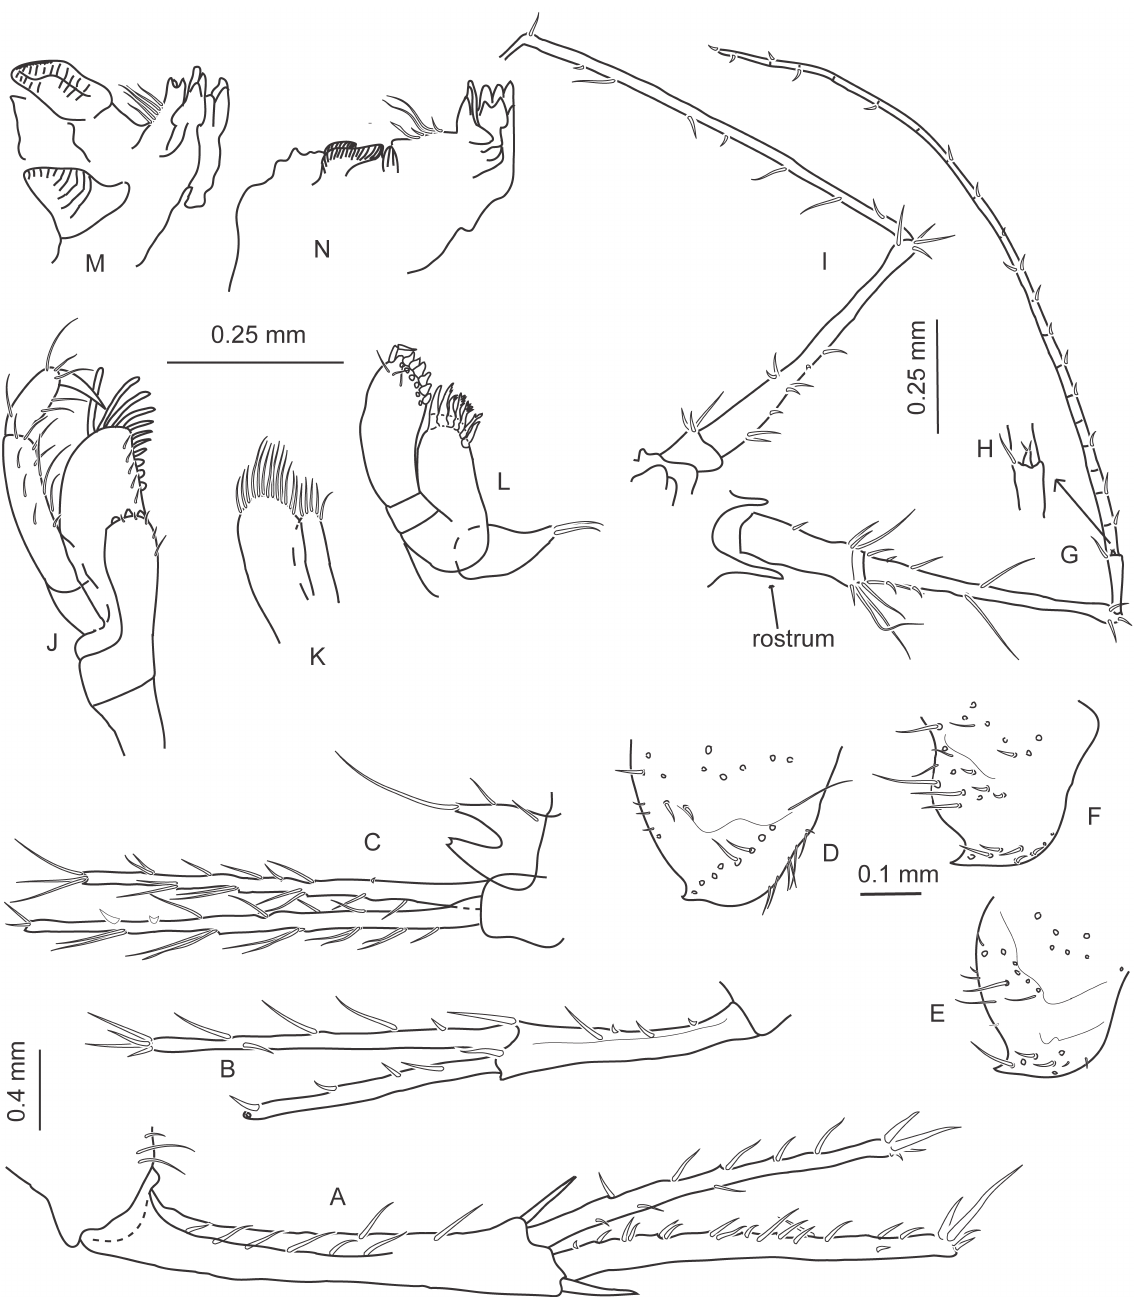
Fig. 11. Lepechinella schellenbergi Stephensen, 1944, lectotype, ♀. A . Left U1. B . Right U2. C . Right U3 and telson. D . Right Ep1. E . Right Ep2. F . Right Ep3. G . Female A1. H . Accessory flagellum. I . Female A2. J . Left Mxp. K . Left Mx2. L . Left Mx1. M–N . Left and right